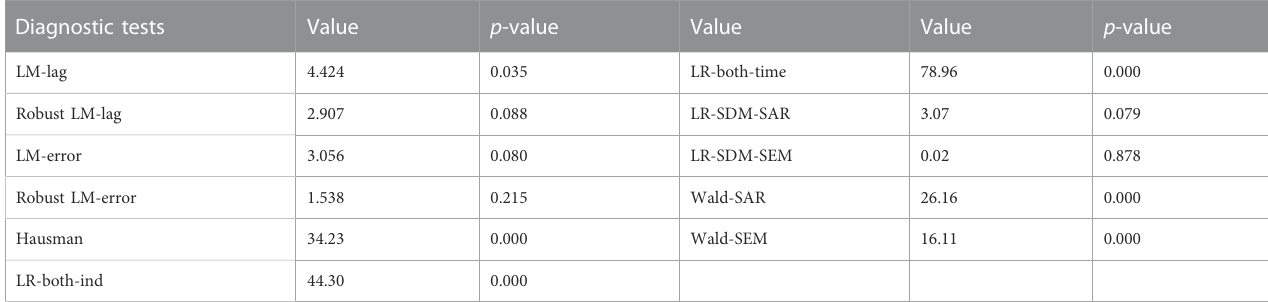
TABLE 6 Model selection test